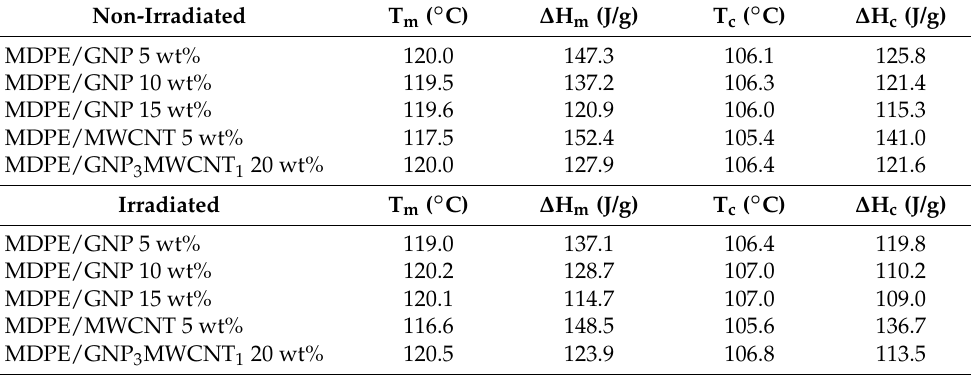
MDPE/GNP 3 MWCNT 1 20